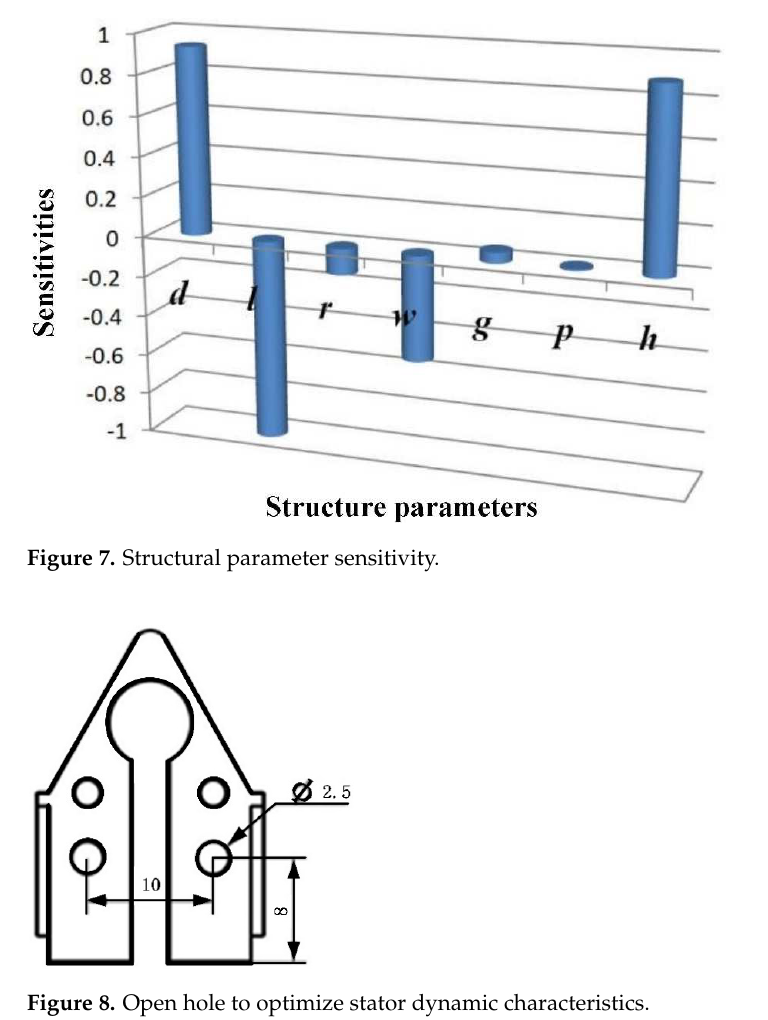
Figure 8. Open hole to optimize stator dynamic characteristics.